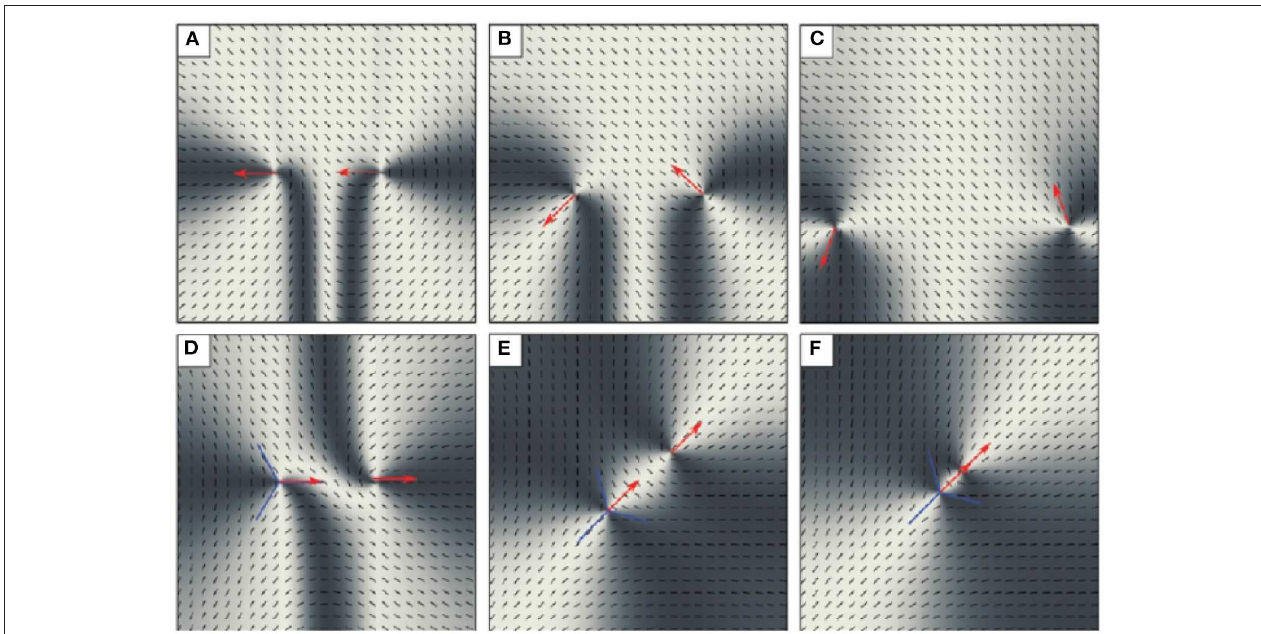
FIGURE 7 | Temporal evolution of a pair of mutually repelling 1 / 2 defects (A–C) and mutually attracting 1 / 2 defects (D–F) , simulated with Neumann boundary + ± conditions, and an initial separation of the defects of 1/3 of the computed region. Red arrows indicate the “tilt,” a quantity introduced to describe the defect orientations. Even though the interconnection vector is initially horizontal in the images, the defect trajectories are curved, and the direction of defect motion noticeably differs from that vector. The image was reproduced from Vromans and Giomi [99], with permission of the Royal Society of Chemistry.